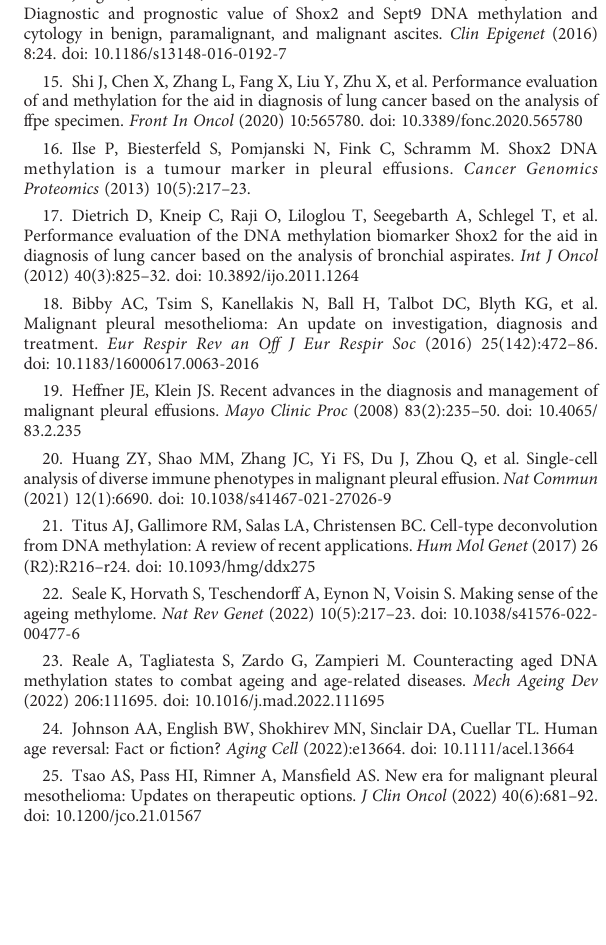
SUPPLEMENTARY FIGURE 1 Frequency distribution of pleural fl uid concentration. SUPPLEMENTARY FIGURE 2 Ampli fi cation curve of HOXA9, RASSF1A, SHOX2 , and SEPTIN9 methylation. (A) Ampli fi cation curve of HOXA9 was evaluated by analyzing 6 different relative HOXA9 concentration (0.4%, 0.8%, 1.6%, 6.4%, 25%,100%) with a total DNA concentration indicated by CtIC (20:2500copies/ul); (B) Ampli fi cation curve of RASSF1A was evaluated by analyzing 6 different relative RASSF1A concentration (0.4%, 0.8%, 1.6%, 6.4%, 25%,100%) with a total DNA concentration indicated by CtIC (20:2500copies/ul); (C) Ampli fi cation curve of SHOX2 was evaluated by